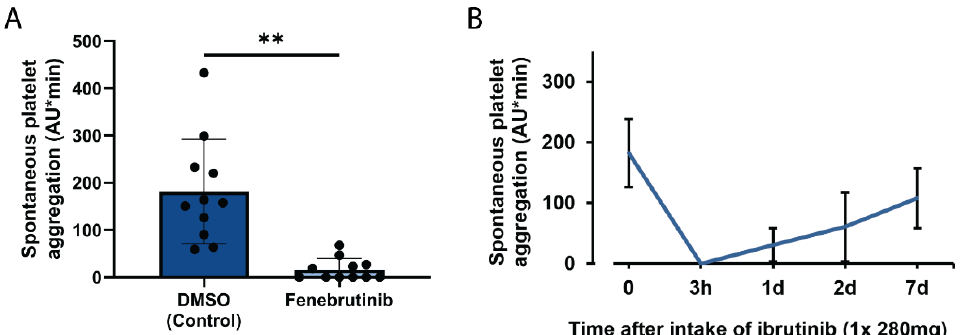
Figure 2. SPA in blood is inhibited by Btk-inhibitors in vitro and ex vivo. ( A ) Effect of the re- versible Btk inhibitor fenebrutinib on SPA in vitro. The blood samples were incubated for 15 min with the solvent control DMSO (0.1%) or with fenebrutinib (50 nM) in the MEA cuvettes, then the stir bar was added, and the measurement (10 min) was started. The values are mean ± SD ( n = 11). ** p < 0.01. The SPA values ranged from 59 to 432 AU*min. ( B ) Effect of oral intake of ibrutinib by a healthy blood donor on SPA ex vivo. SPA was measured before, and 3 hours (h), 1, 2, and 7 days (d) after intake of Imbruvica ® (280 mg). Representative results of one of three donors are shown. The values are means ± SD of triplicate determinations.